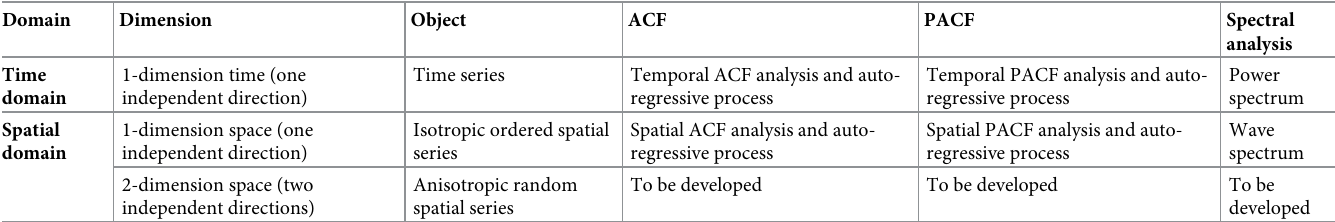
Table 3. A comparison of the analytical processes of autocorrelation functions and related